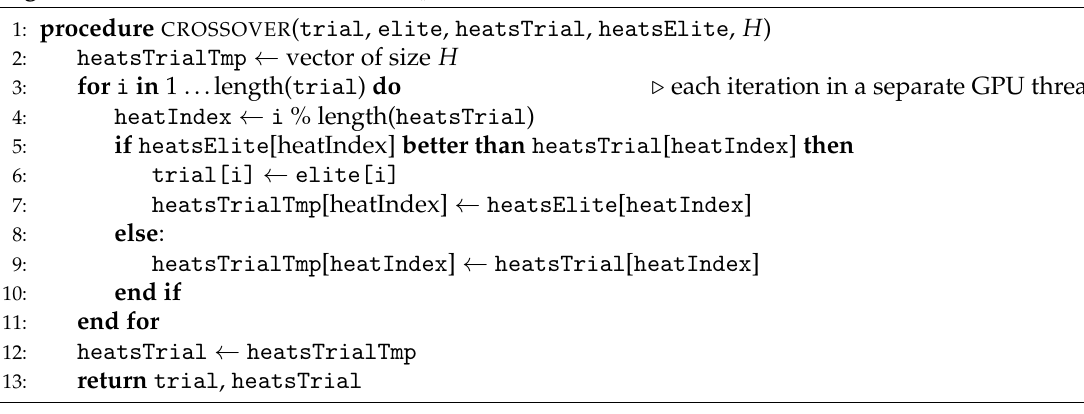
Algorithm 11 Discrete cGA: crossover().